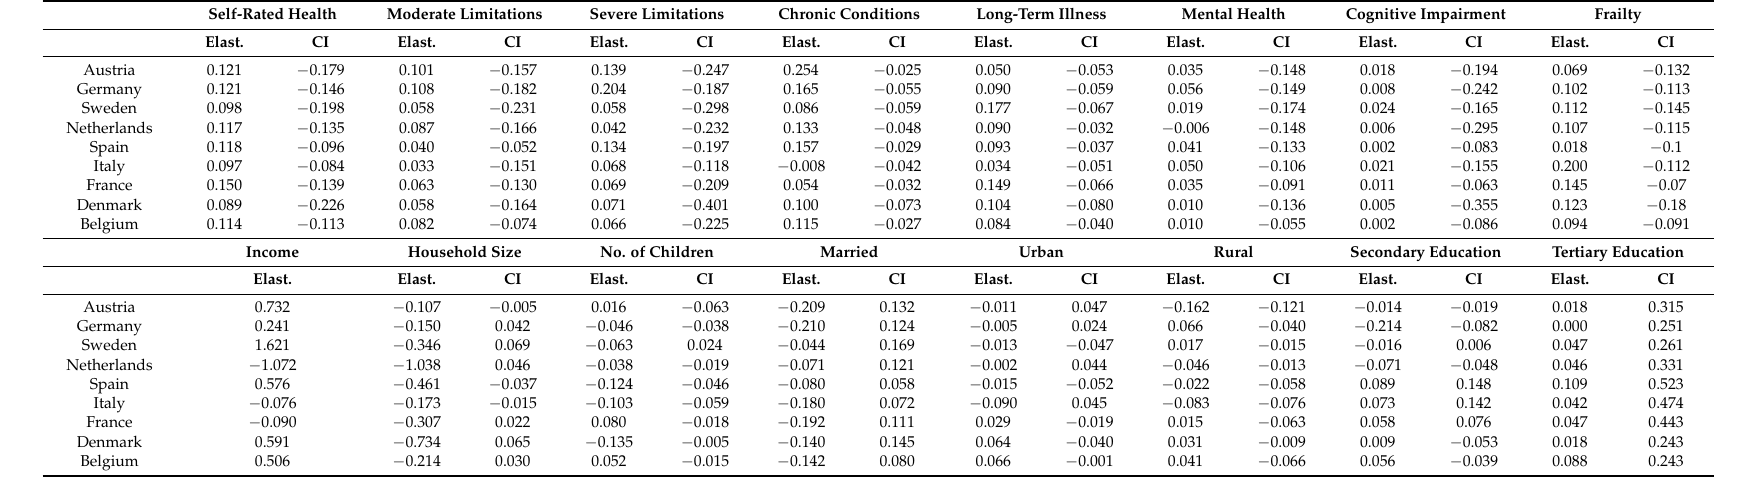
Table 3. Decomposition results (selected need